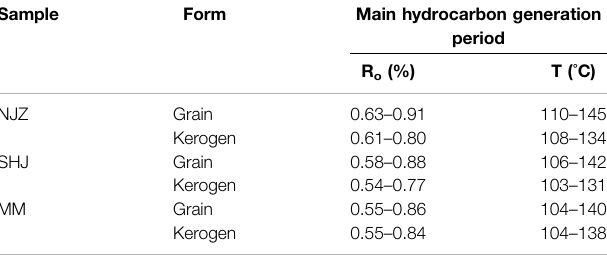
TABLE 3 | Division of the main hydrocarbon generation period of three samples.